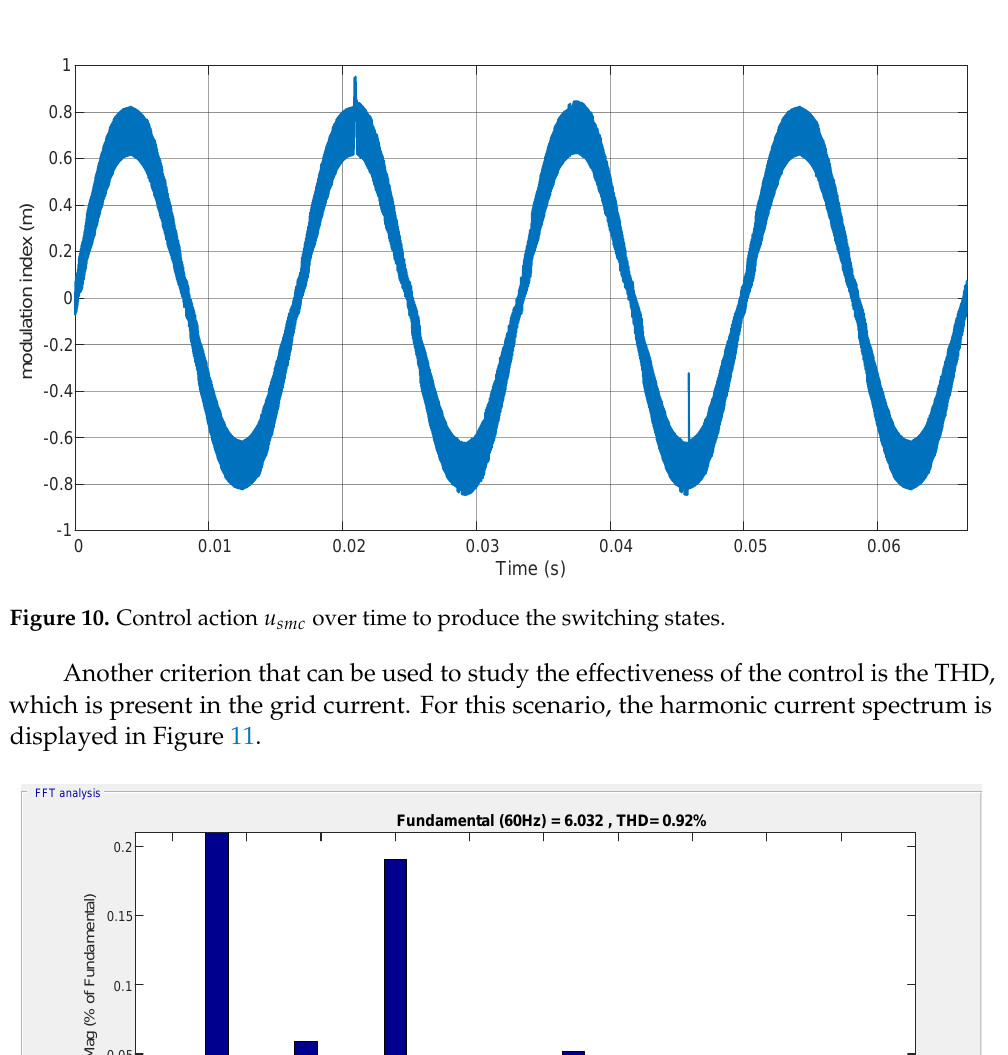
Figure 9. Tracking error between currents 𝑖 1∗ and 𝑖 1 .